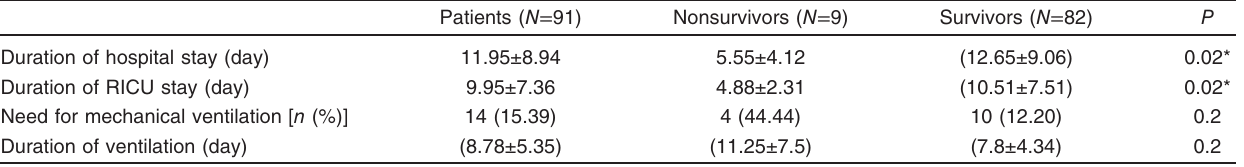
Table 5 Respiratory intensive care units outcomes for patients with interstitial lung